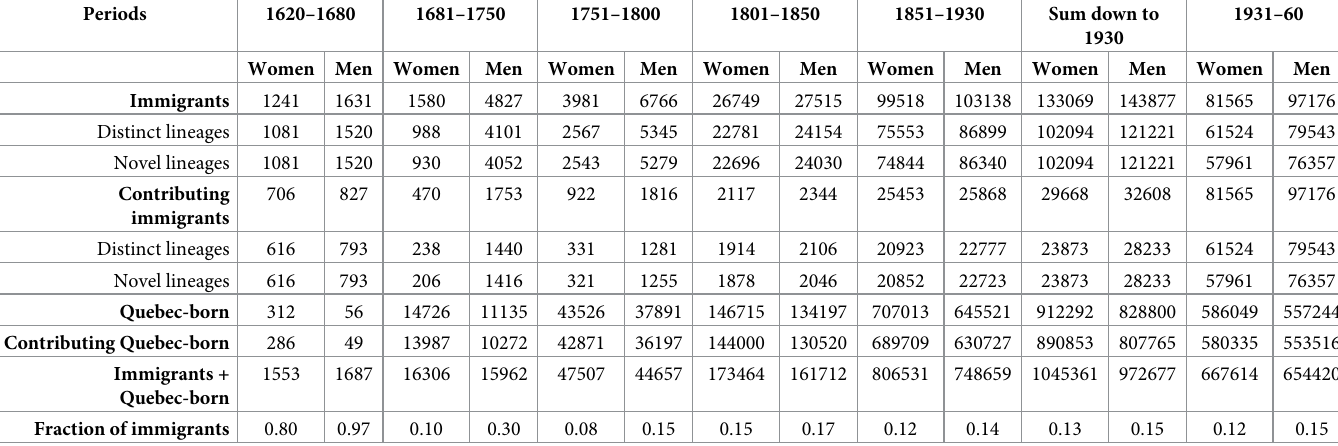
Table 1. Numbers of immigrants and Que´bec-born individuals who married in Quebec in five historical periods. Numbers of distinct and novel (newly introduced, i.e., in addition to those already present and introduced earlier), uniparentally inherited lineages (separately maternal and paternal) are reported as well. Contributing immigrants are those who transmitted their descendant lineages in the 1931–60